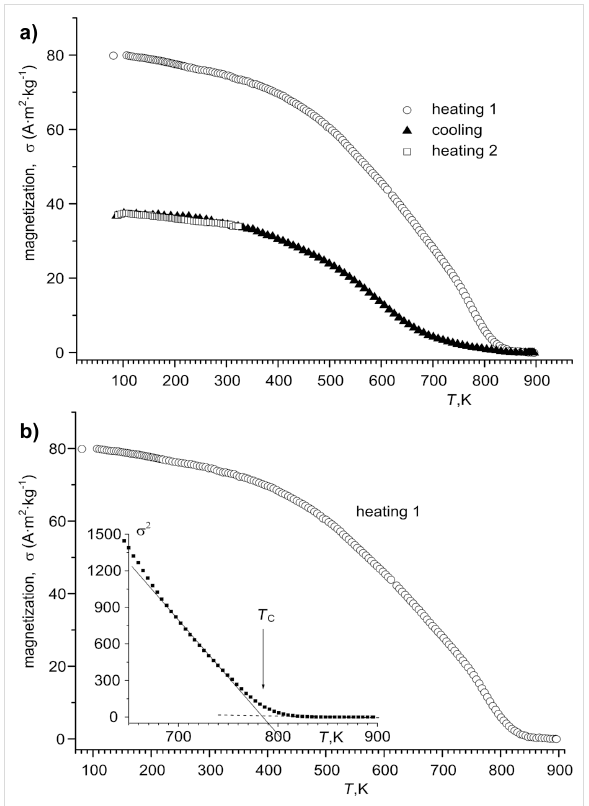
Figure 7: Magnetization as a function of the temperature for Ni–Fe NWs fabricated in the alumina template (a) with H PA = 65 μ m at a cur- rent density of 3 mA·cm − 2 , the deposition duration was 90 min; (b) the same and the inset is the σ 2 ( T ) dependence. The dashed line repre- sents a linear fit to the experimental data. The arrow indicates the eval- uated T C